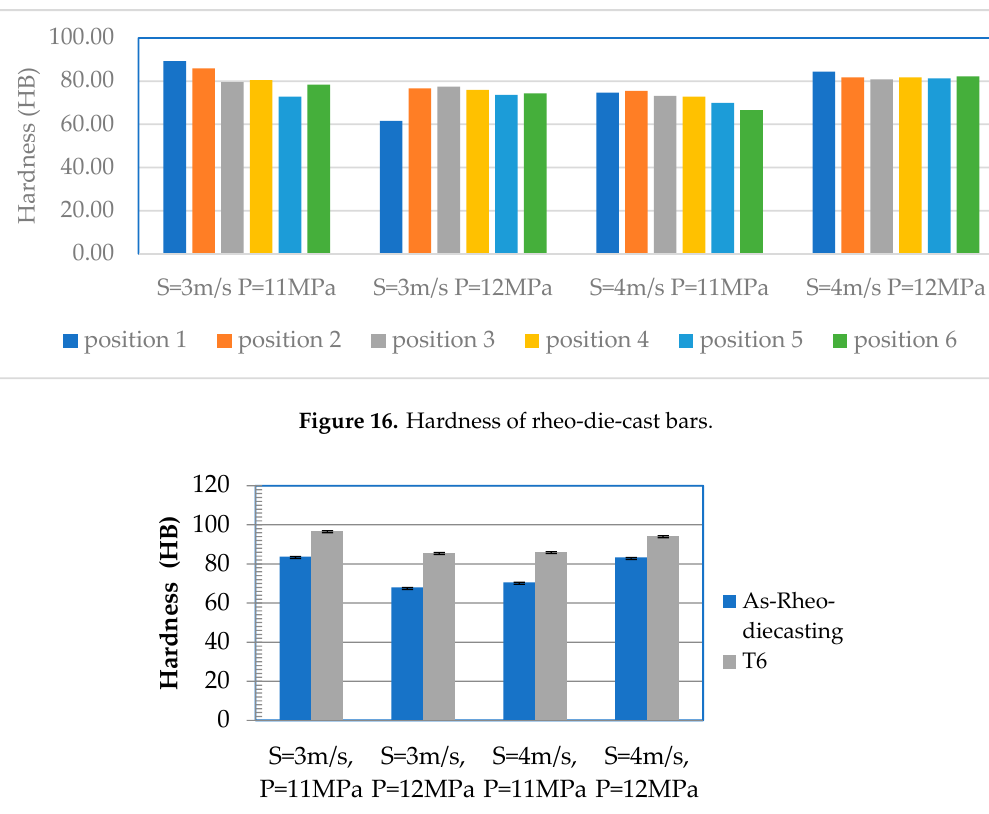
Figure 17. Average hardness of rheo-die-cast A356 / SiC(15%SiC-15 µ m) of position 1 and 6 .